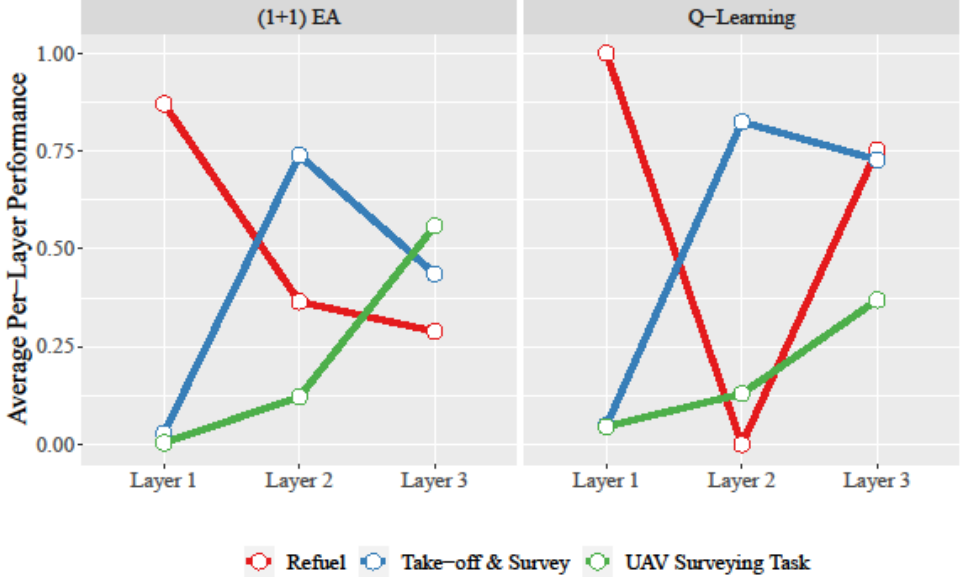
Figure 4. Subtask performance for the (1+1) EA ( left ) and Q-learning ( right ) approaches at the end of each elapsed layer.